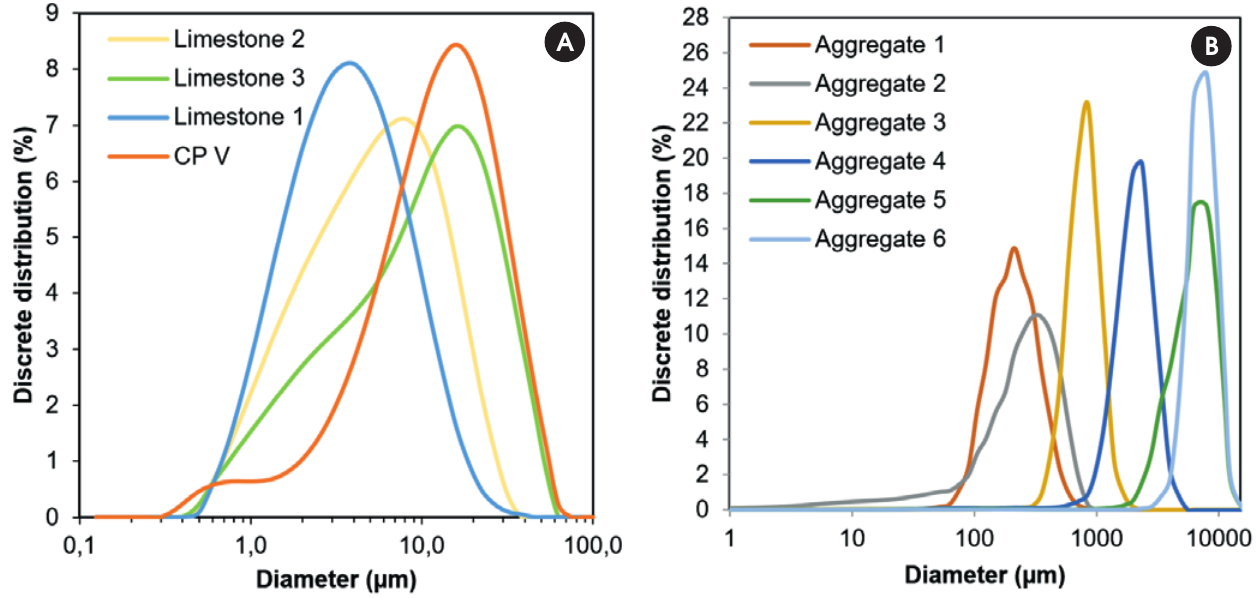
Particle size distribution of materials: a) fines (cement and limestone filler, d < 125 μm); b) thick (aggregates – sand and gravel, d > 125 μm)